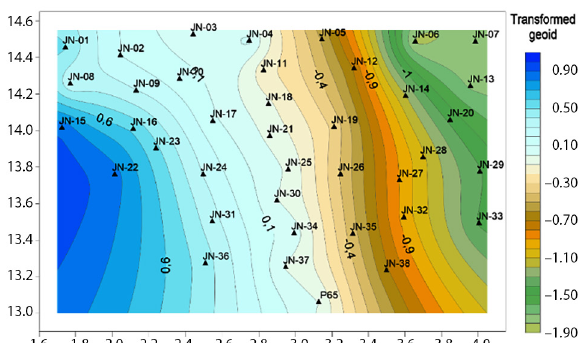
Fig. 8. Relative geometric geoid from transformed coordinates